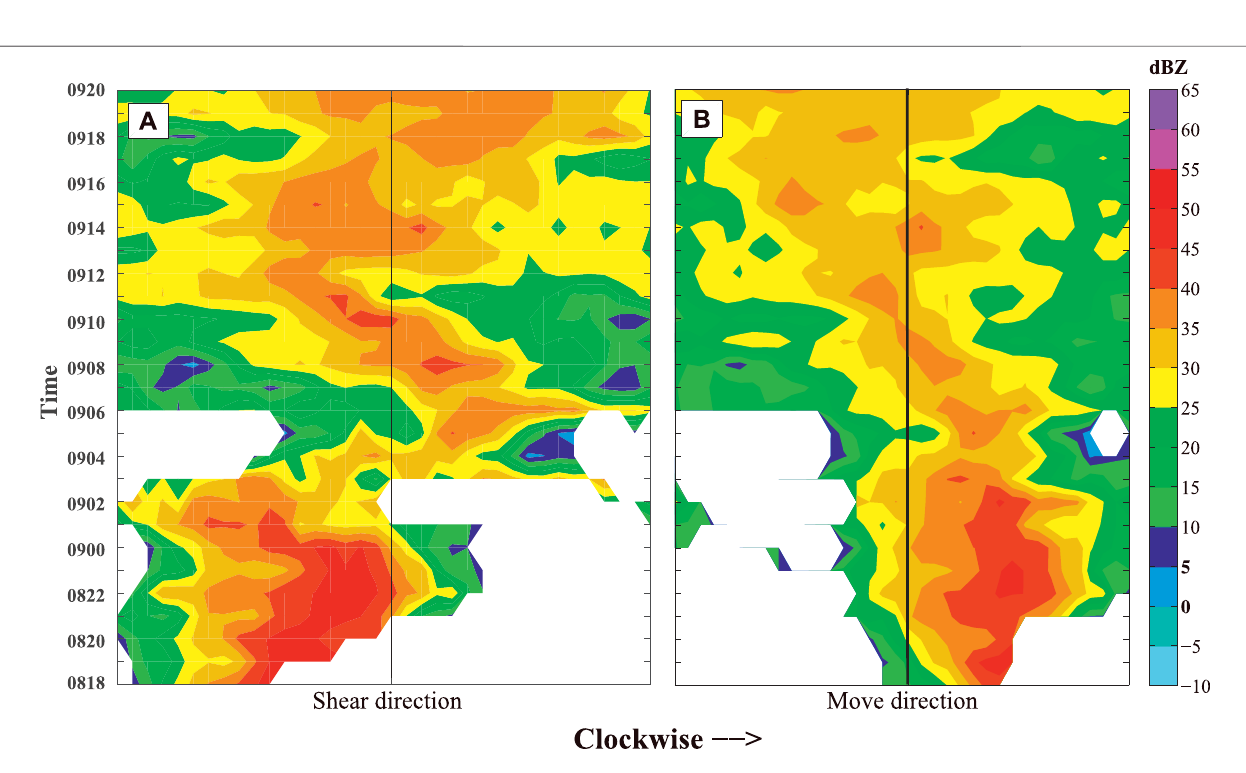
Frontiers in Earth Science |